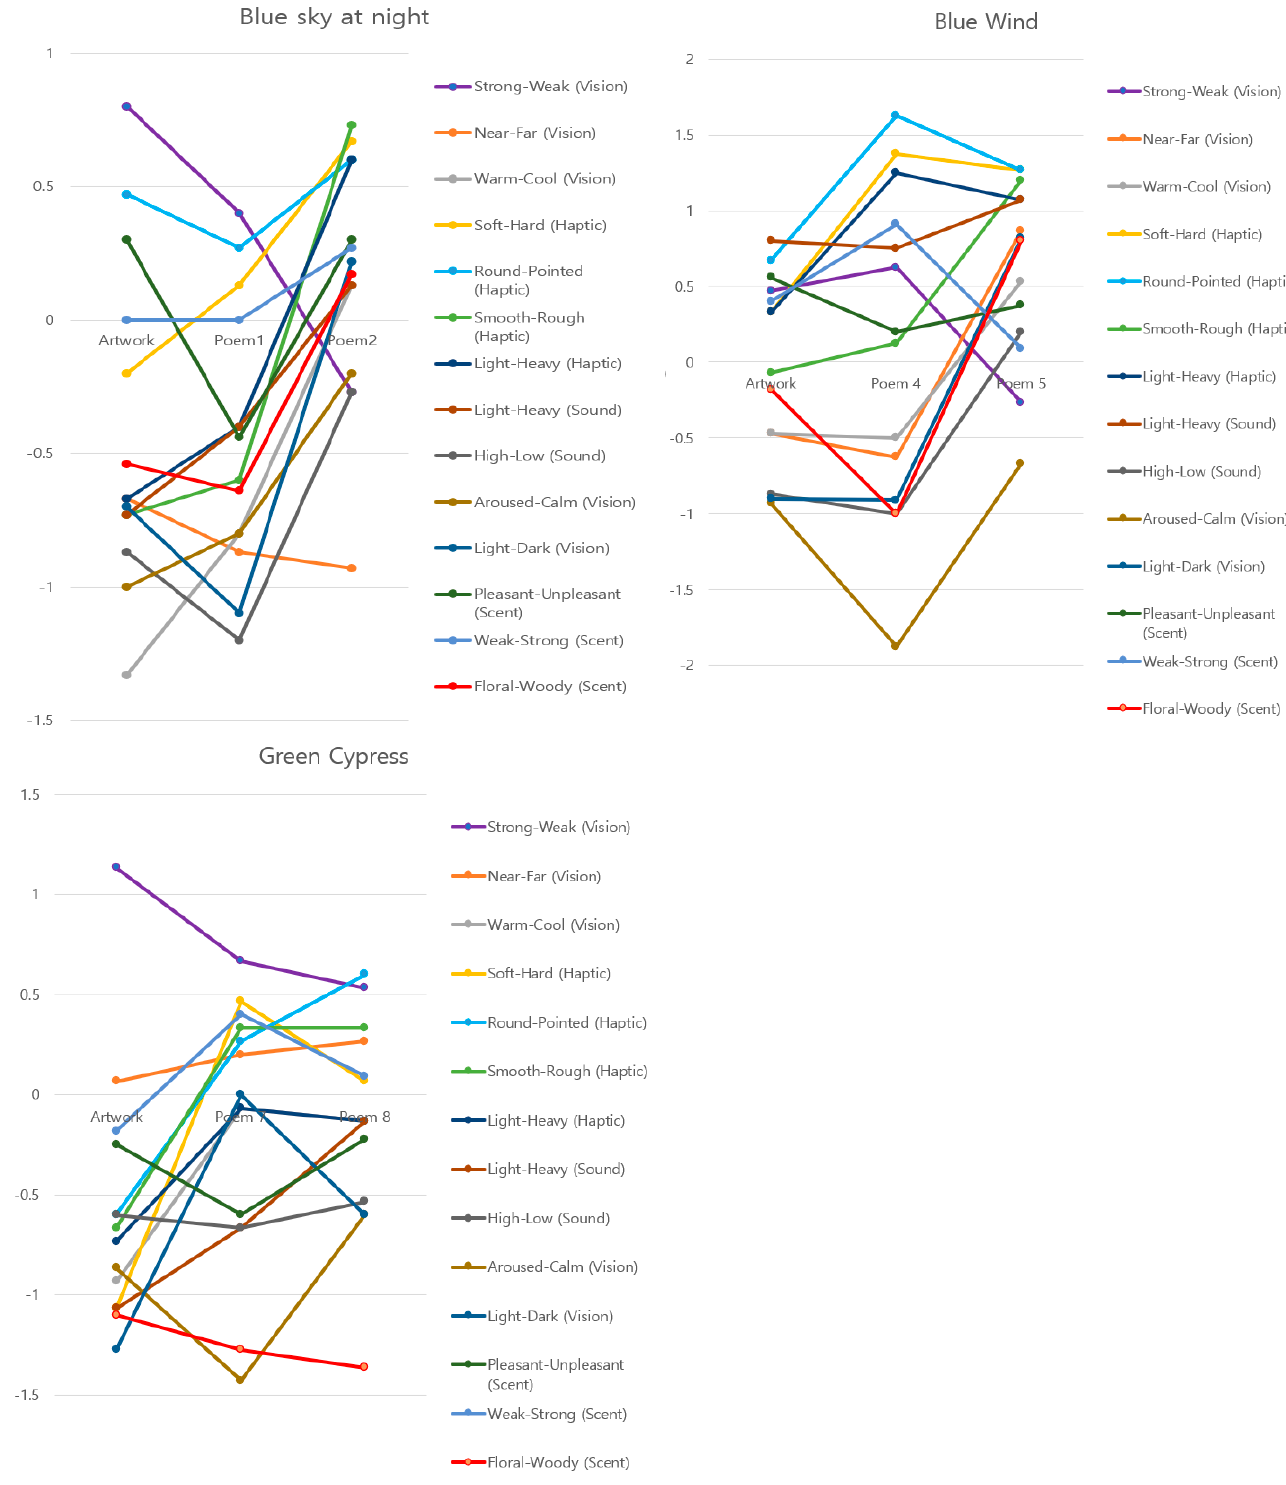
Figure 4. Comparison of response to semantic differential similarity between artwork and two poems with respect to various sensations (showing graphical representation to visualize the similarity between the artwork and two poems).